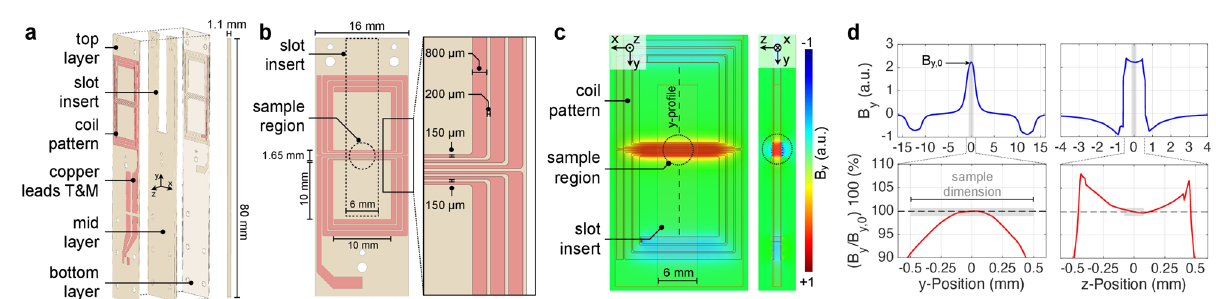
Figure 2. ( a ) Comparison between a thermal (160 averages, 10× scaled) and the ODNP enhanced 1 H spectrum 50 mW, 16 averages). ( b ) Measured 1 H ODNP enhancements (130 nL of 15 mM TEMPOL in DI water, P MW ≈ as a function of the applied MW input power. Three concentrations of TEMPOL in DI water are shown (sample volume always 130 nL). ( c ) ODNP build-up curve as a function of MW radiation time (see text for details). ( d ) Measured 1 H ODNP enhancement profile. Shown are the NMR signal peak values plotted versus the available (cid:31) B -field range of the B 0 -field sweep coil (centre B 0 -field strength was 4940 G).